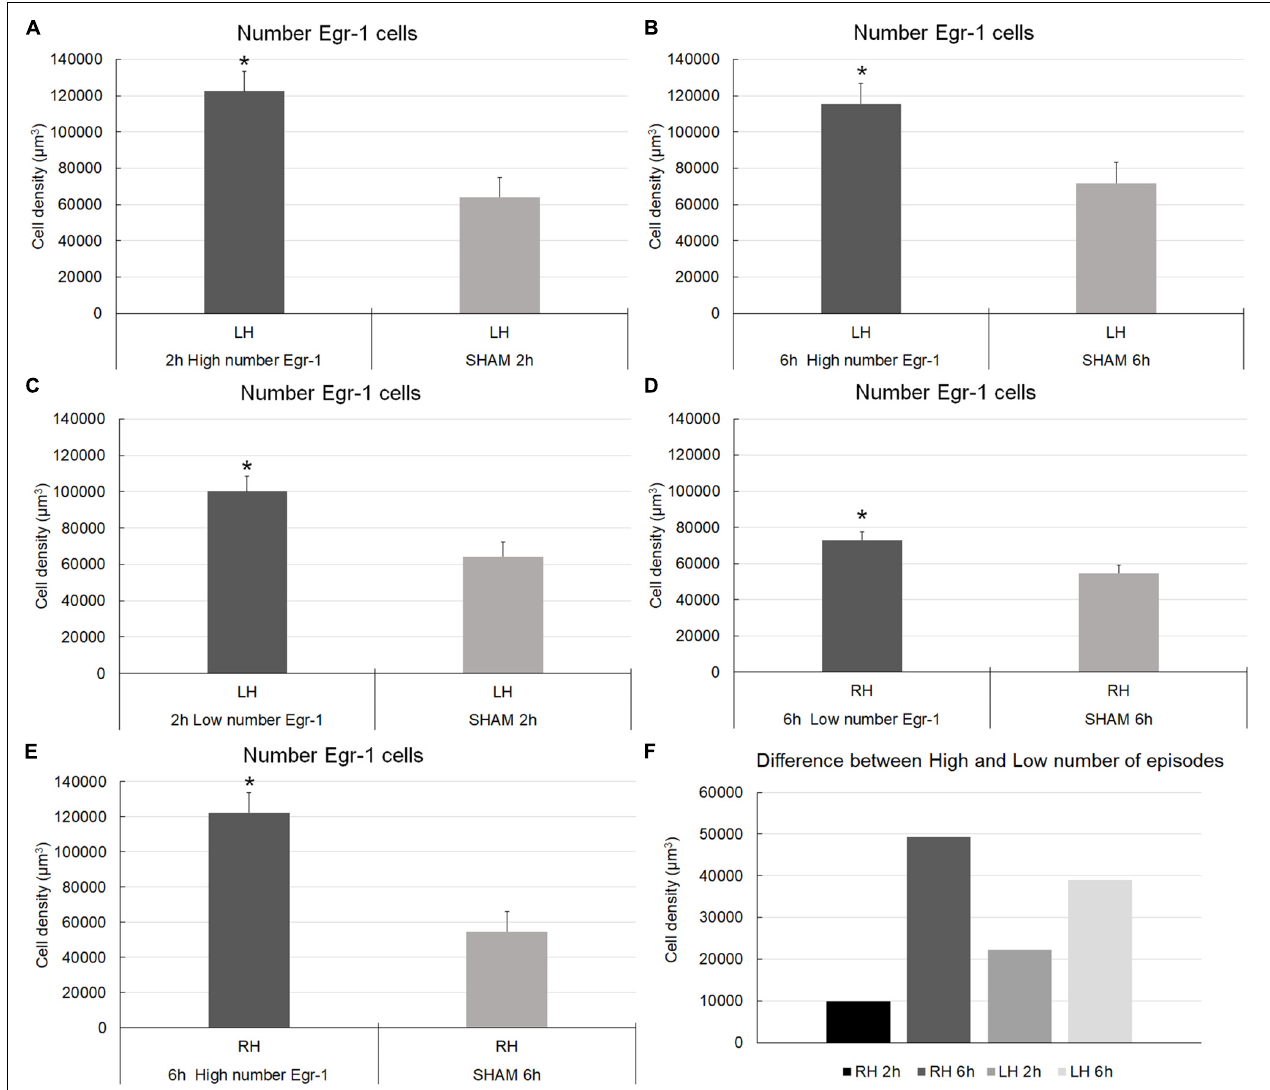
FIGURE 6 | Graphic representation of the density of Egr-1–positive cells in the somatosensorial cortex. The graphs show stereological estimates of Egr-1–positive cell density ( µ m 3 ; mean) in the infragranular layers of the somatosensorial cortex according to the indicated recording time (2 or 6 h) and according to the number of episodes of cortical spreading depression (high number and low number). (A–E) ( ∗ ) Statistically significant differences (parametric statistical analyses using t -tests – with samples with equal and unequal variances); (F) Differences in mean of stereological numerical estimates between the groups (higher number of CSD episodes minus who showed smaller number of episodes); overall significance level, 0.05; 2 and 6 h, 2 and 6 h of recording; high and low number, high and low number of CSD episodes; sham, zero